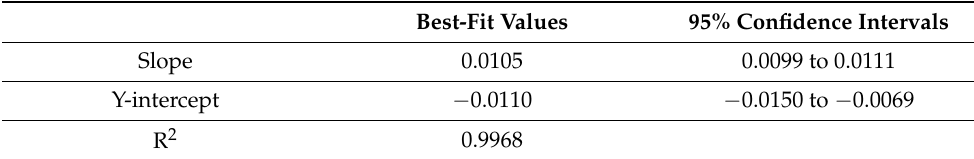
Figure 4. ( A ) Absorbance spectra of calibration samples with constant SFN mass and increasing mass of RA; ( B ) Calibration curve obtained from eight samples measured in triplicate. Some error bars not visible due to the low SD. Table 1. Calibration curve parameters.